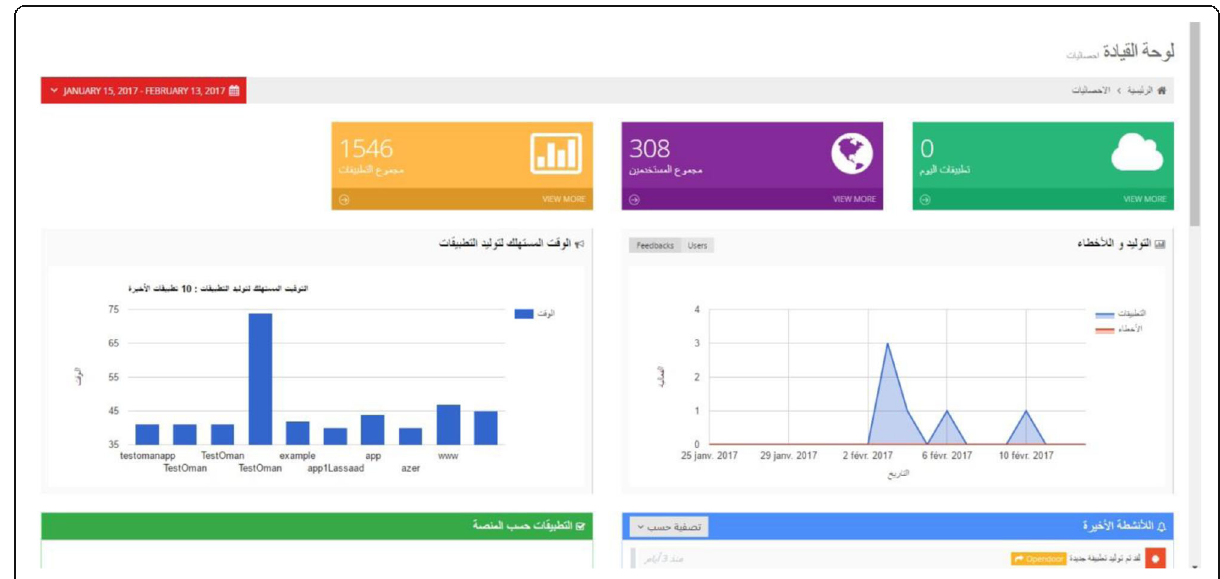
Fig. 14 ALECSO APPs Editor ’ s Front and back stats